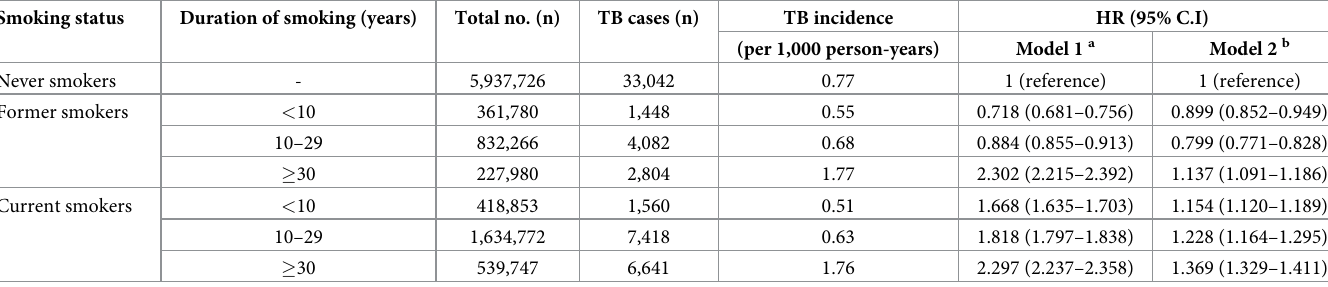
Table 4. Incidence and risk of tuberculosis according to smoking